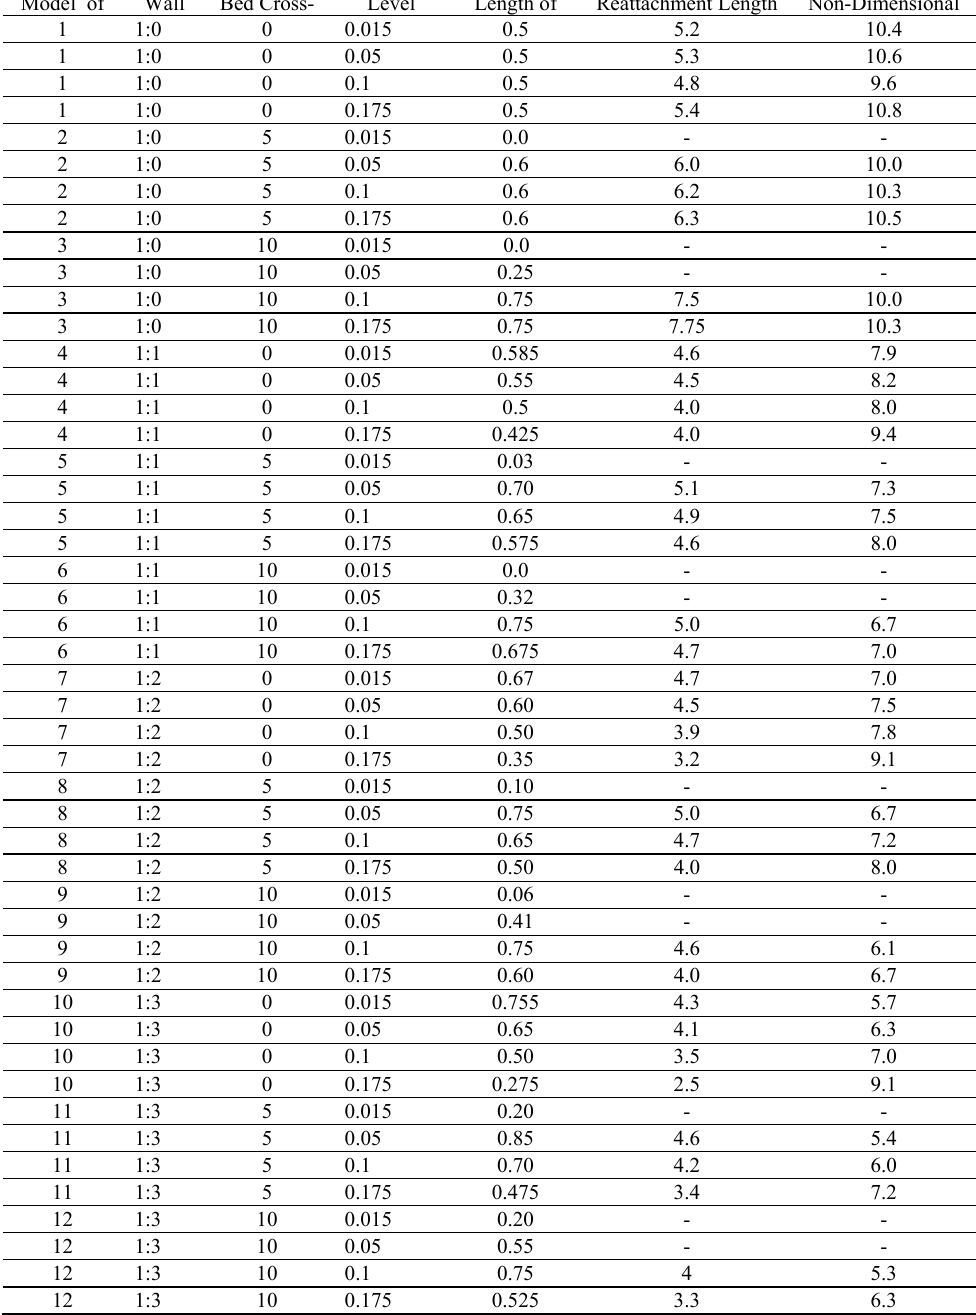
Table 3 Reattachment length at the various water levels for the various bed and structural